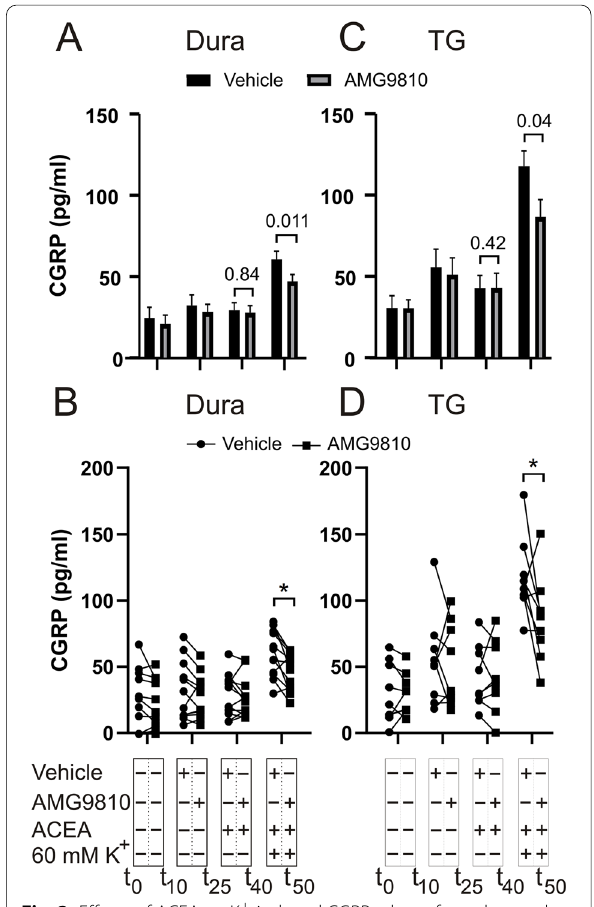
Fig. 3 Effects of ACEA on K + -induced CGRP release from dura and TG in the presence of AMG9810. A Application of 140 nM ACEA in the presence of AMG9810, did not cause a significant increase in CGRP release from the dura ( n 12). KCl (60 mM K + ) caused a significant = increase in CGRP release, which in the presence of 1 μM AMG9810 was significantly attenuated by ACEA. B Graphical illustration of the sample pairing. C Application of 140 nM ACEA had no effect on the CGRP release from the TG per se, but significantly inhibited the release induced by 60 mM K + ( n 12) in the presence of 1 μM = AMG9810. D Graphical illustration of the sample pairing. B baseline. = Timeline in minutes are added on the lower panel. Data are shown as mean SEM or their individual data points with pairing, and with ± p values obtained with Student’s T-test being depicted in the graph (* p < 0.05). For reference 100 pg/ml equals 26.4 =